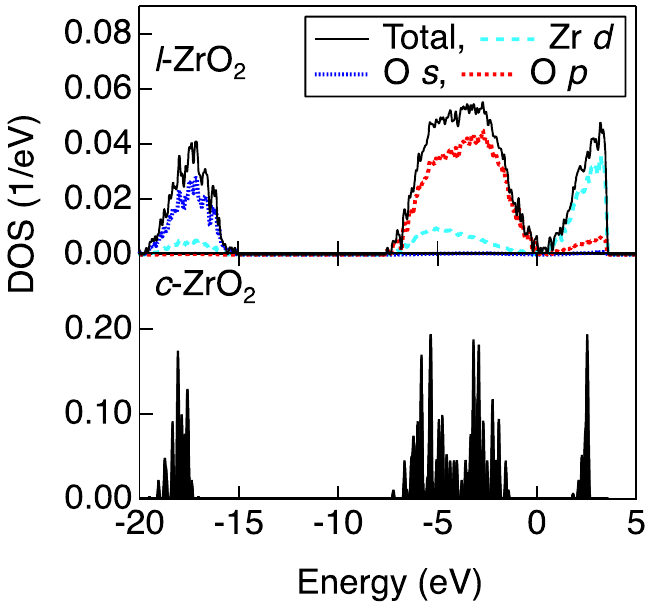
Figure 4. Density of States (DOS) and its projections onto atomic orbitals for the higher valence bands and conduction band [7].